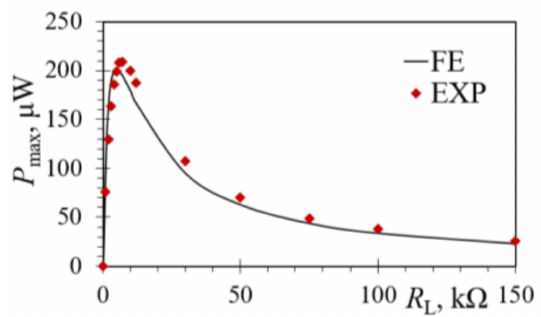
Figure 16. Comparison of experimental and FE power outputs vs. R L for a harmonically excited rectangular bimorph PEH